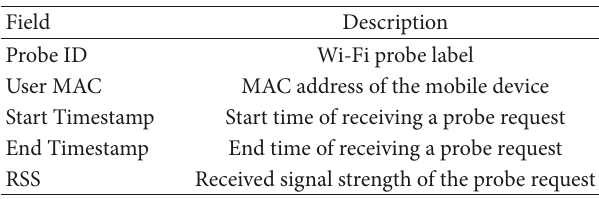
Table 1: Description of Wi-Fi